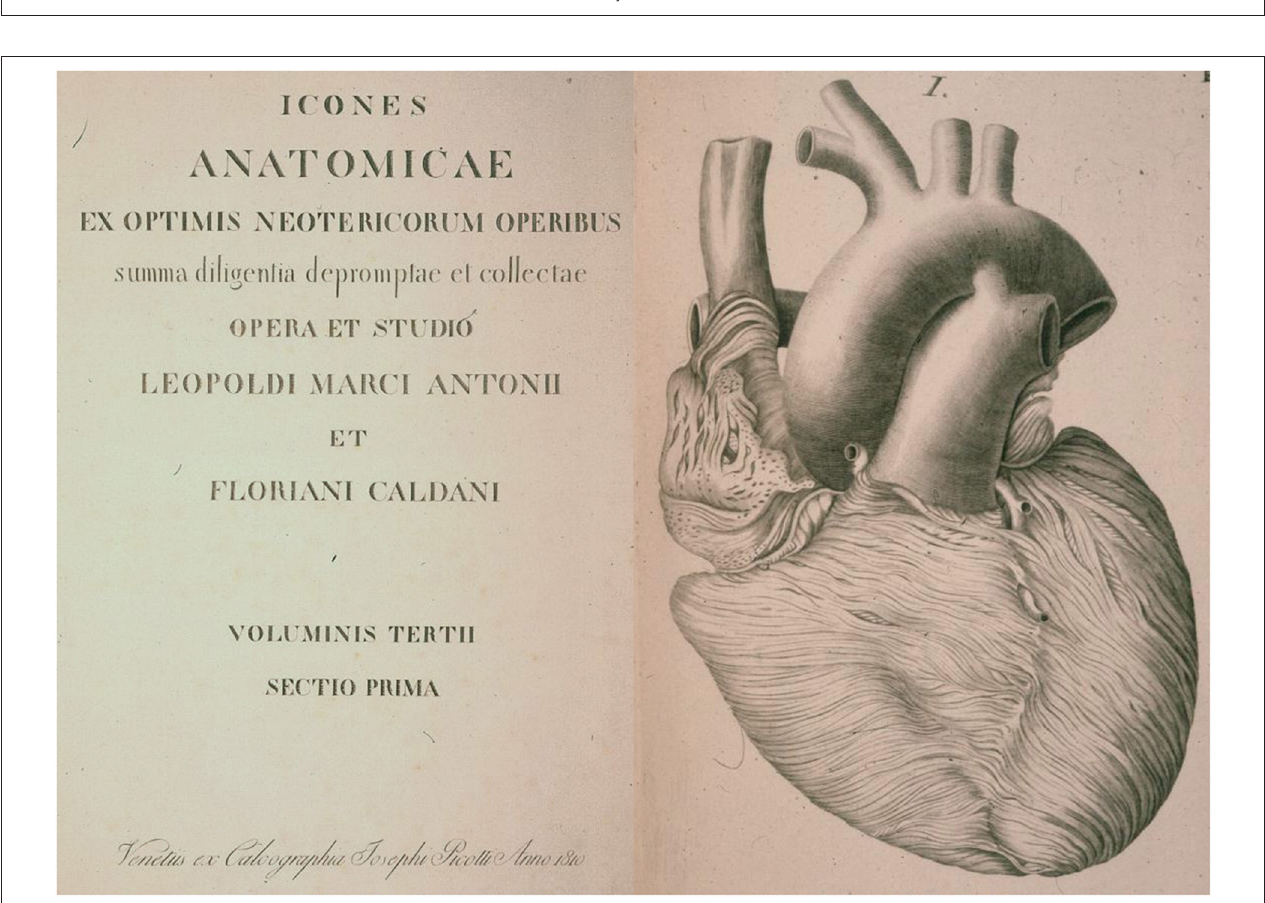
FIGURE 9 | The first historical description of myocardial bridge made in 1834 by Leopoldo and Floriano Caldani, Professors of Anatomy at the University of Padua. From Caldani et al. (8).